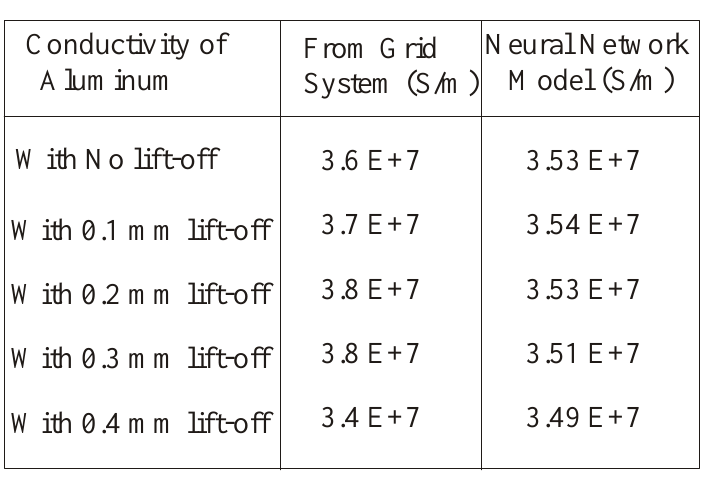
Table 4. Comparison of